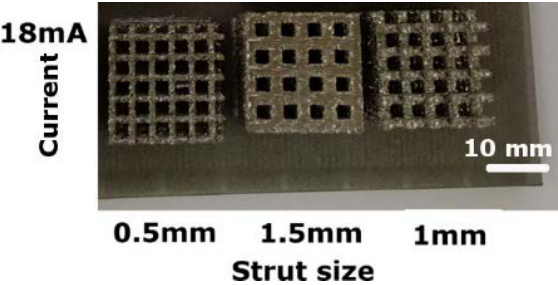
Figure 9. Intact γ -TiAl porous blocks built with 0.5 mm struts by EBM with the modified scan strategy.